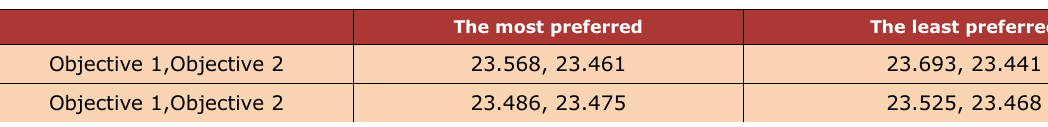
Table 9. The most and the least preferred of objectives